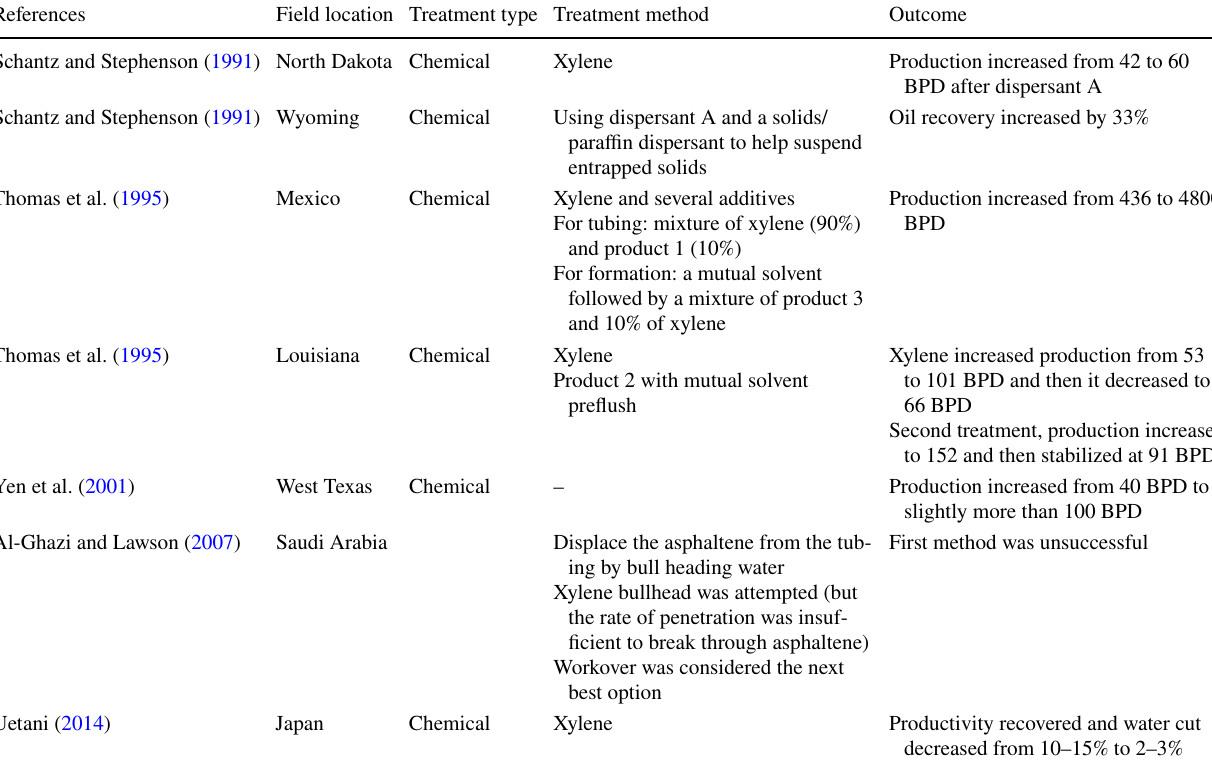
Table 10 Asphaltene treatment methods and their